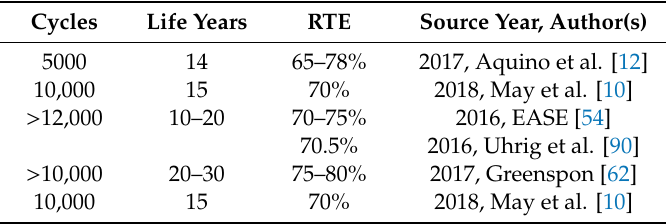
Table 18. Cycles, life years, and RTE—redox flow technology.